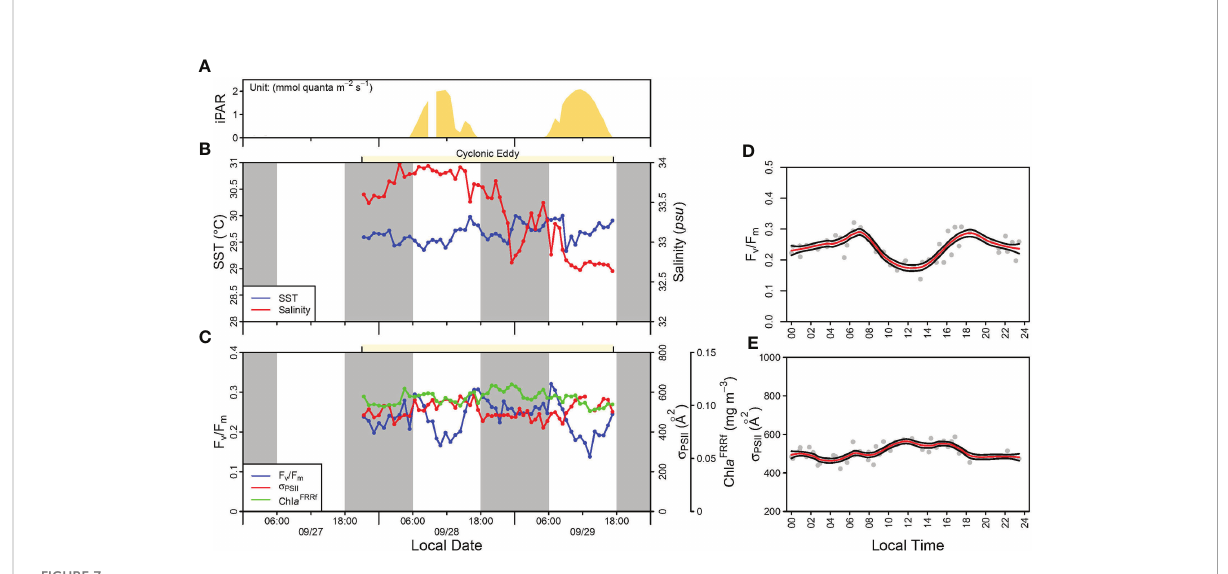
FIGURE 7 Same as Figure 5 but for eddy domains in the Western SCS (Section S3).